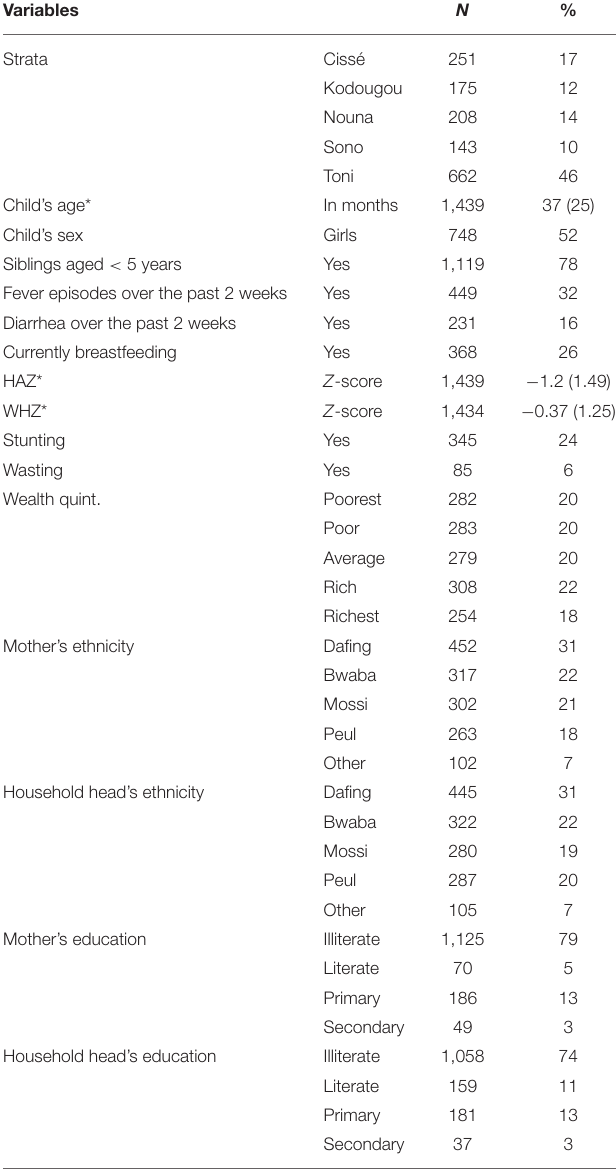
TABLE 1 | Characteristics of the study population ( N = 1,439). Variables N